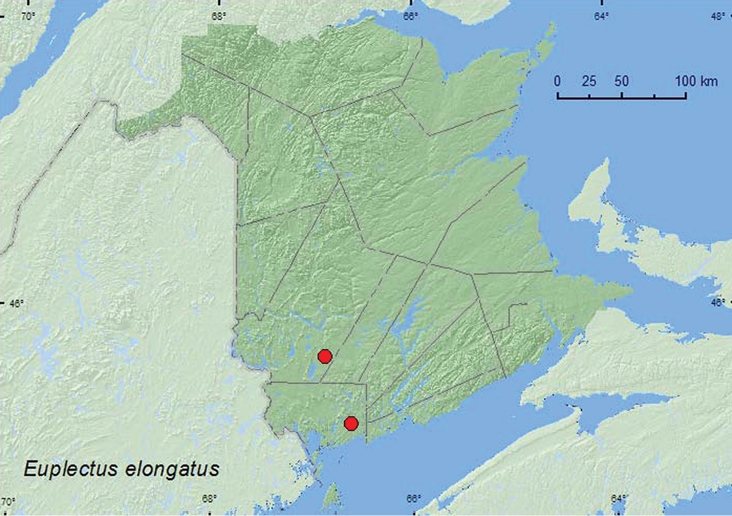
Collection localities in New Brunswick, Canada of Euplectus elongatus.